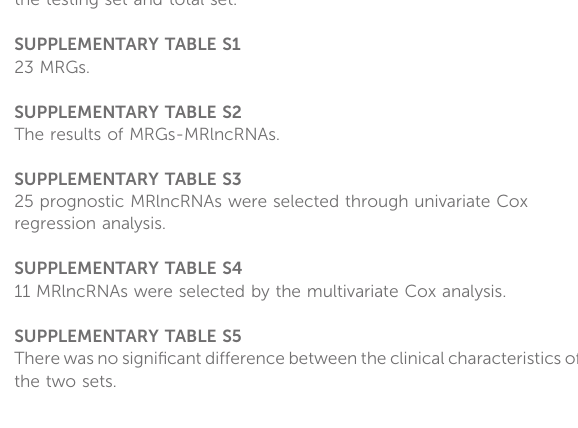
SUPPLEMENTARY FIGURE S1 (A) 25 prognostic MRlncRNAs recognized by univariate Cox analysis. (B – E) Kaplan-Meier survival curves, and 1, 3 and 5-year ROC curves in the testing set and total